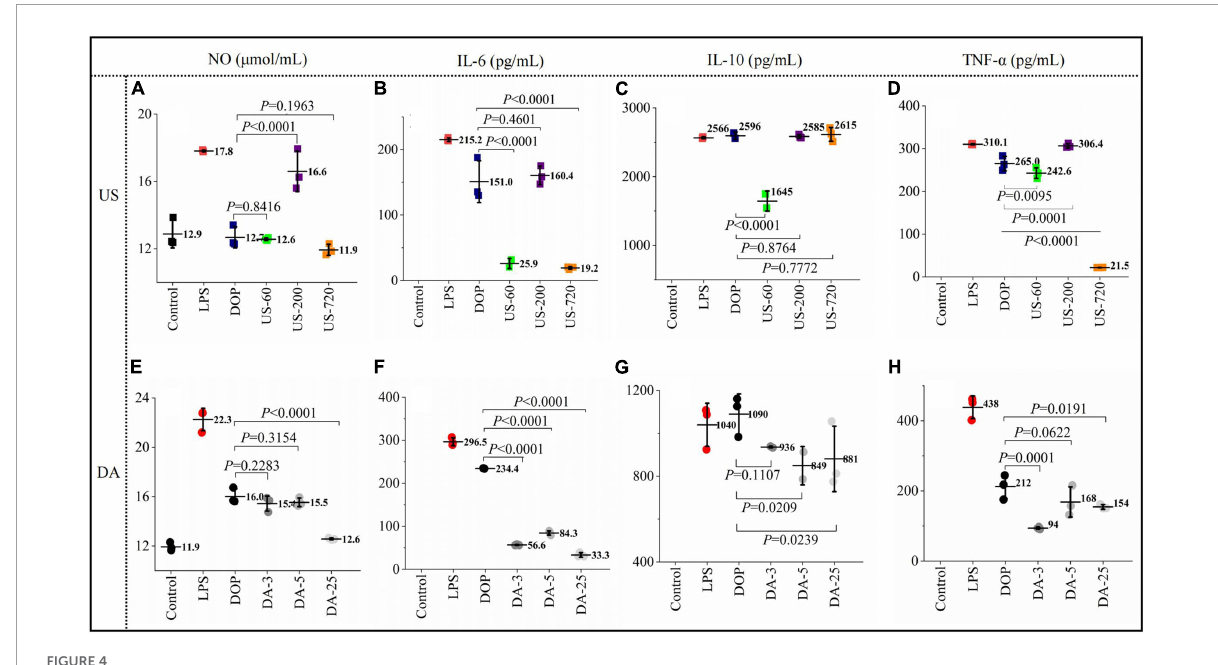
FIGURE4 Polysaccharides induced production of immune factors NO (A,E) , IL-6 (B,F) , IL-10 (C,G) , TNF- α (D,H) productions (24 h) by macrophages RAW264.7 exposed to ultrasonic and de-acetylated samples (100 µ g/ml) were assessed by ELISA. All data are representative of at least triplicate culture.